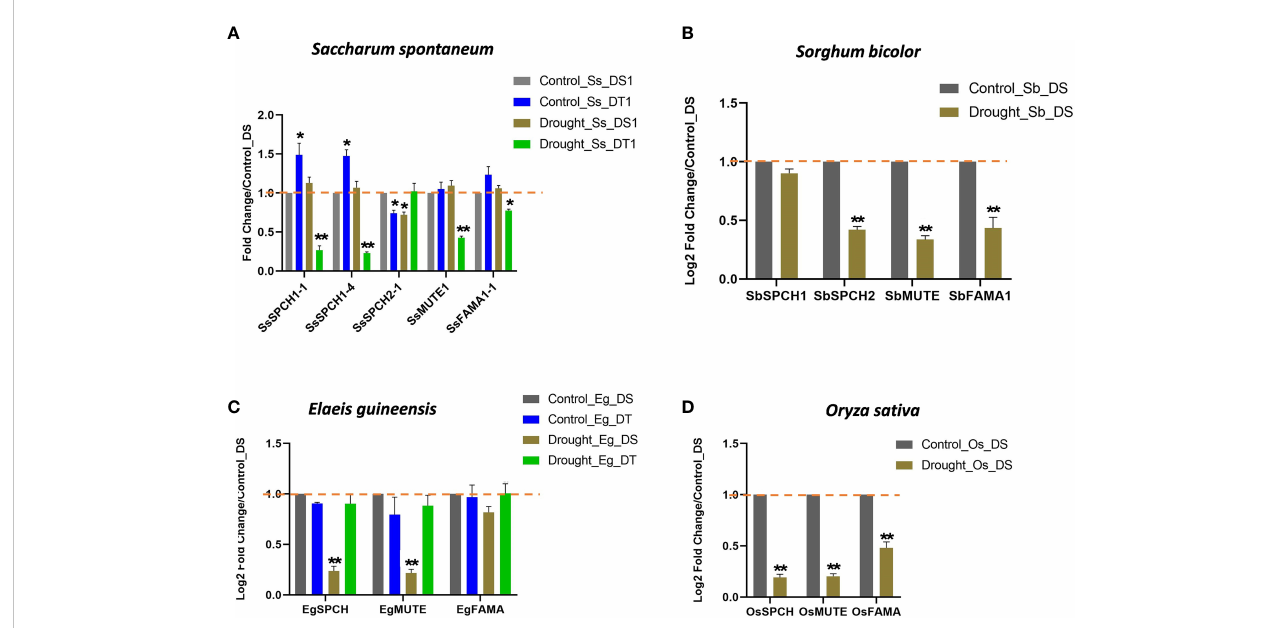
FIGURE 4 The relative expression levels of SPCH , MUTE and FAMA in (A) the drought-susceptible and tolerant Saccharum spontaneum ; (B) Sorghum bicolor; (C) the drought-susceptible and tolerant Elaeis guineensis and (D) Oryza sativa . Triplicates were included in the Q-PCR, the expression level of drought- susceptible plants under control was standardized to 1. The values are mean ± SEM; n ≥ 3. One-way ANOVA with post hoc Tukey HSD; *, p <0.05; **,